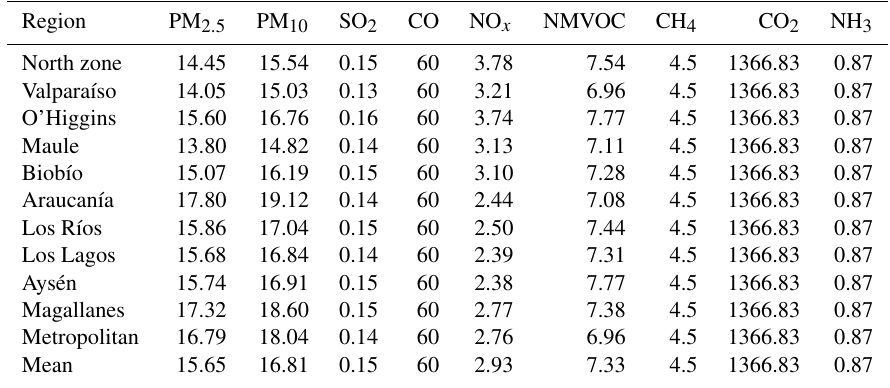
Table A2. Aggregated emission factors (gkg − 1 ) at a regional level for each pollutant used in the residential